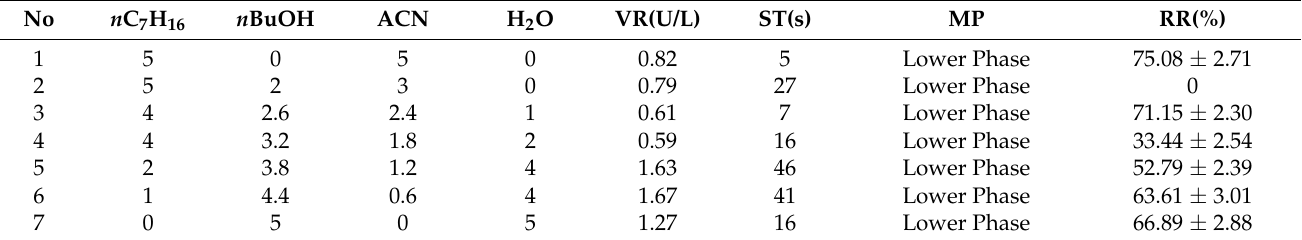
Table 4. The retention rate of n -heptane– n -butanol–acetonitrile–water solvent